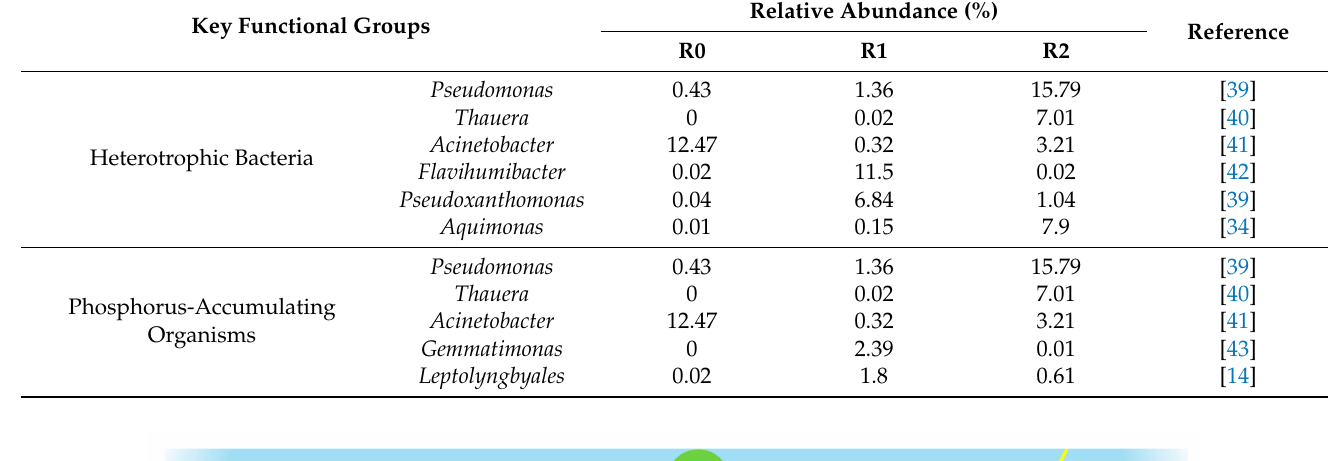
Table 1. The potential key functional microbial groups at the genus level.